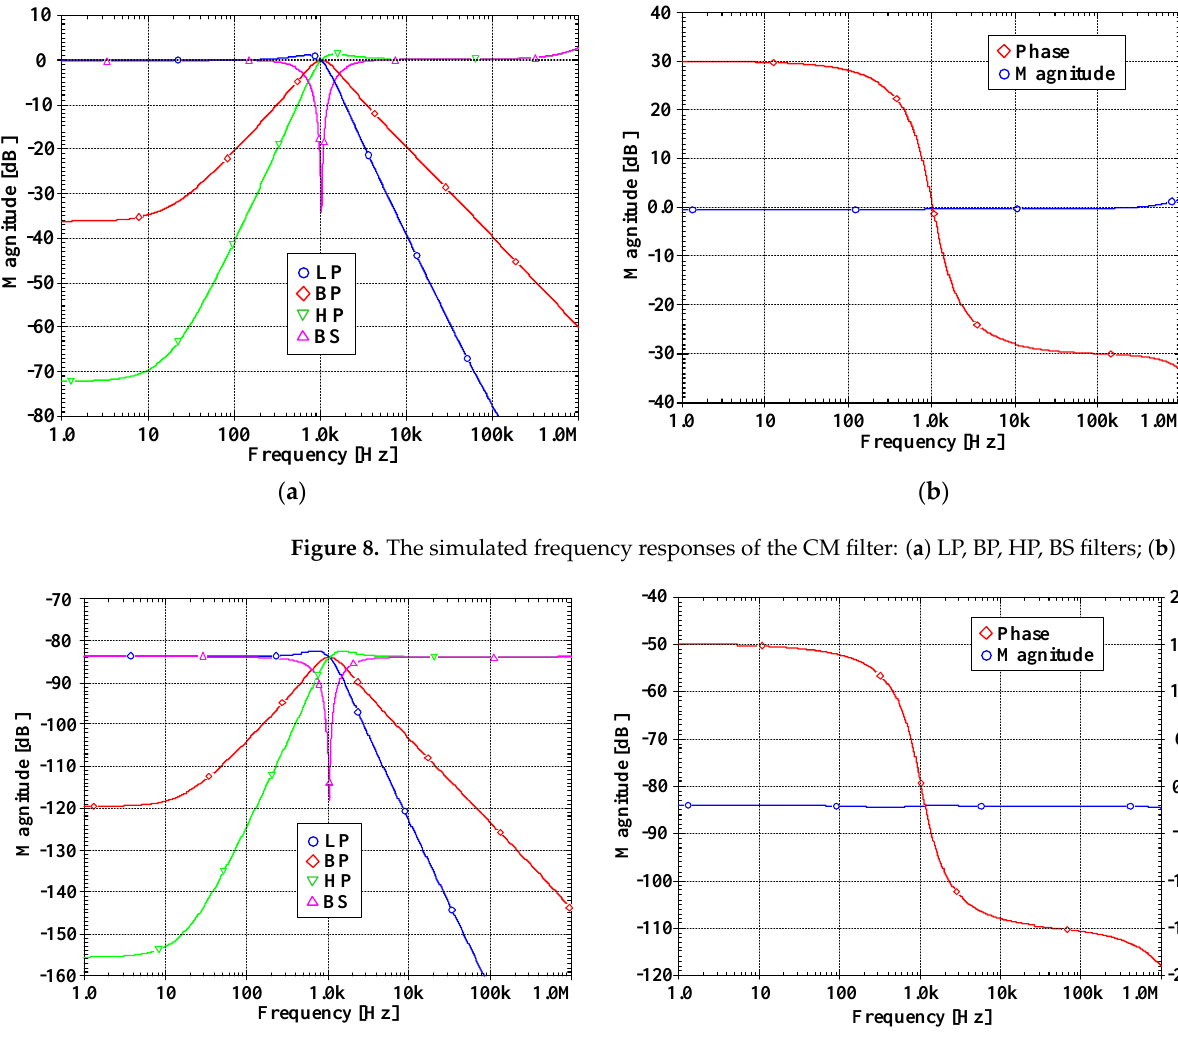
Figure 7. The simulated frequency responses of the VM filter: ( a ) LP, BP, HP, BS filters; ( b ) AP filter.